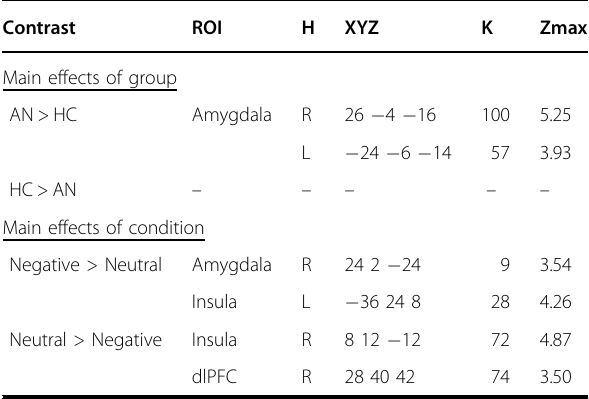
Table 2 Results of ROI analyses for phase (2) RX- fMRI